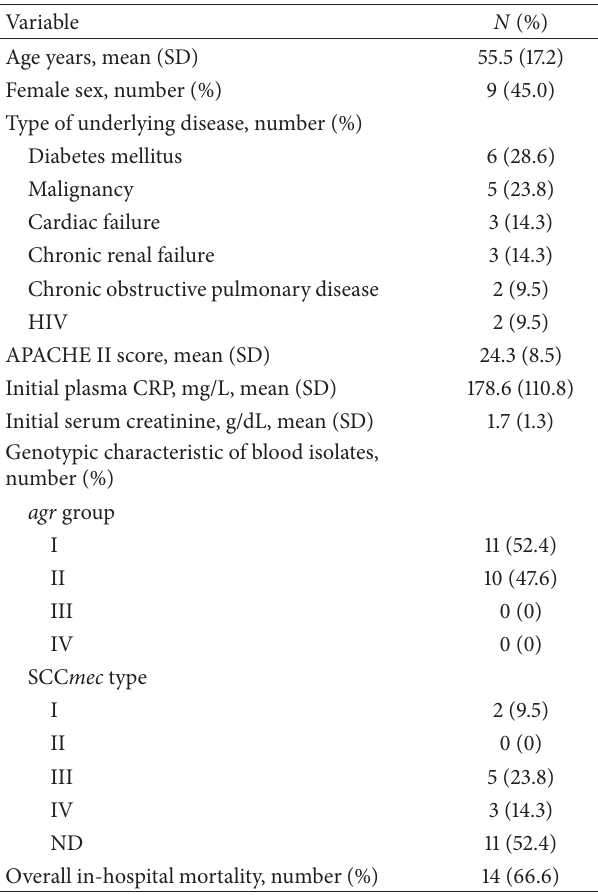
Table 1: Characteristics of the patients with MRSA